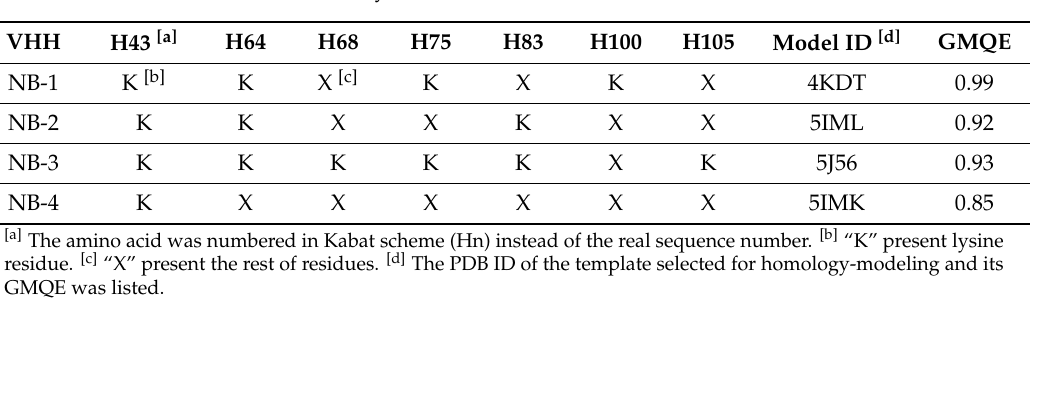
Table 1. The statistic of lysine residues’ location in the selected four